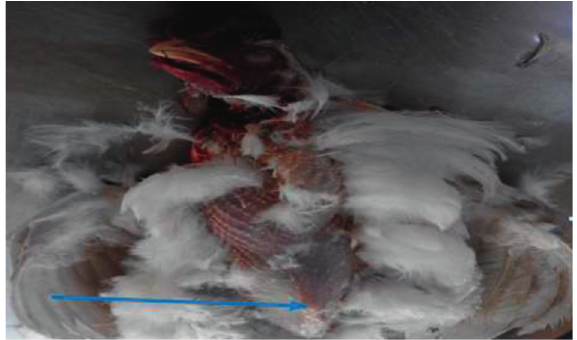
Figure 5: Arrow showing the prominent keel bone and wasting of the breast muscle observed on the avian intradermal tuberculin test positive chicken upon postmortem